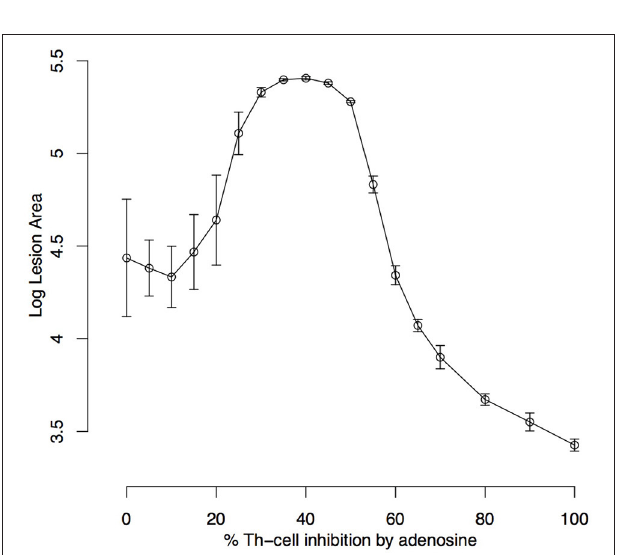
FIGURE 6 | Simulated lesion area with respect to adenosine inhibition over Th cells. Simulations were run for 480 iterations (6 weeks) with the settings k1 = 0.001%, k2 = 0%, k3 = 18%, k5 = 35%, φ IL 12 = 1 and Ado inhibition rate over Th cells (k4) varying from 0 to 100%. Lesion peaks measured as the log of the number of dead epithelial cells were reported. Each dot represents the average ± standard deviation of 10 simulations.